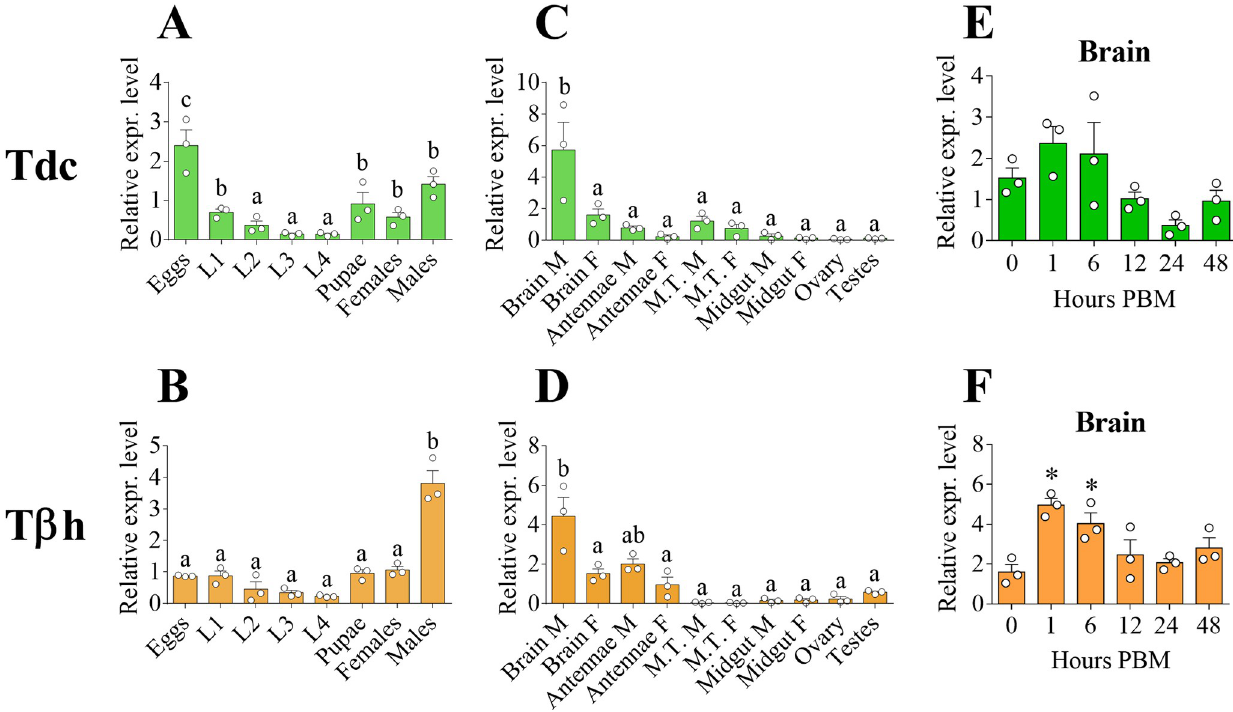
Fig 8. Expression patterns of the enzymes involved in TA and OA biosynthesis: Tyrosine decarboxylase ( Tdc ) and tyramine β -hydroxylase ( T β h ). The transcript levels were investigated among development stages ( A, B ), several tissues collected from male and female adult mosquitoes ( C, D ) and female adult A . aegypti brains post blood meal (PBM) time points ( E, F ). Data represent means ± SEM of three biological replicates. Statistical significance of p < 0.05 is indicated by different letters in panels A-D. � p < 0.05 vs pre blood-fed condition (0 hours PBM) in panels E and F according to one-way ANOVA followed by multiple comparisons Bonferroni post hoc test. Malpighian tubules (MTs); male (M); female (F).